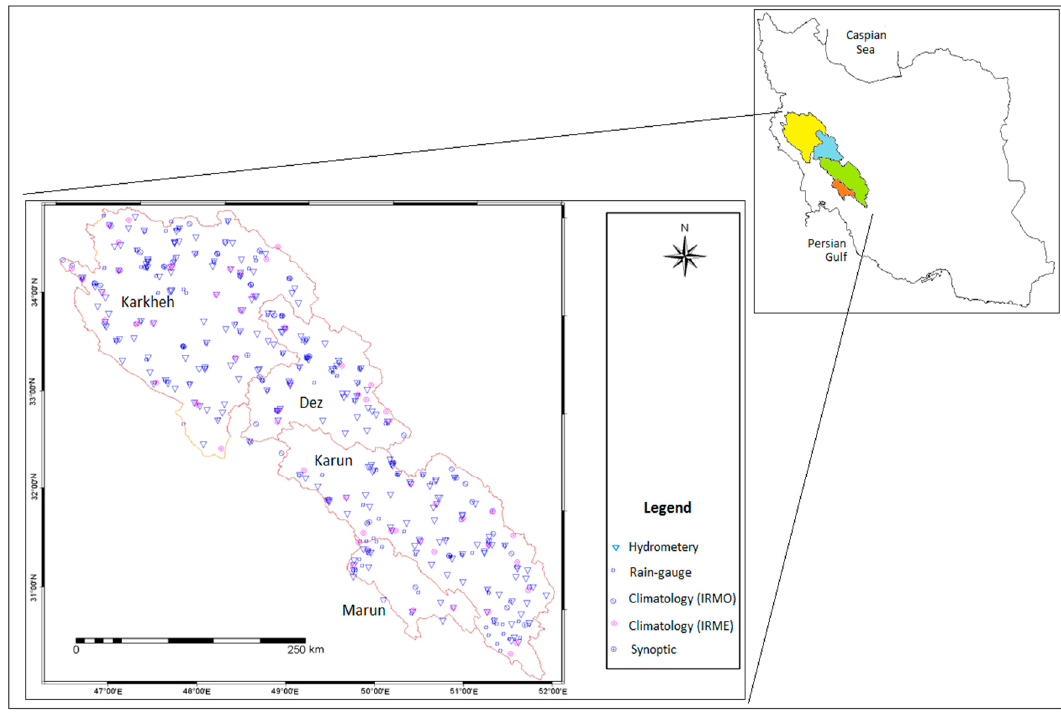
Figure 1. Location of the study basins and distribution of the meteorological and hydrometric stations.